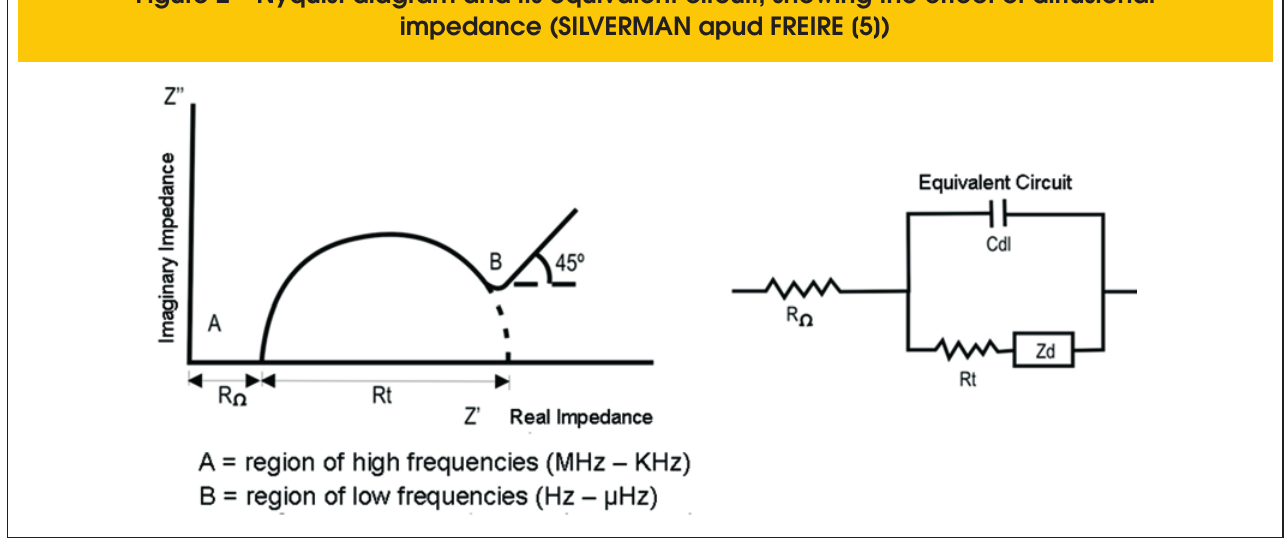
Figure 2 – Nyquist diagram and its equivalent circuit, showing the effect of diffusional impedance (SILVERMAN apud FREIRE